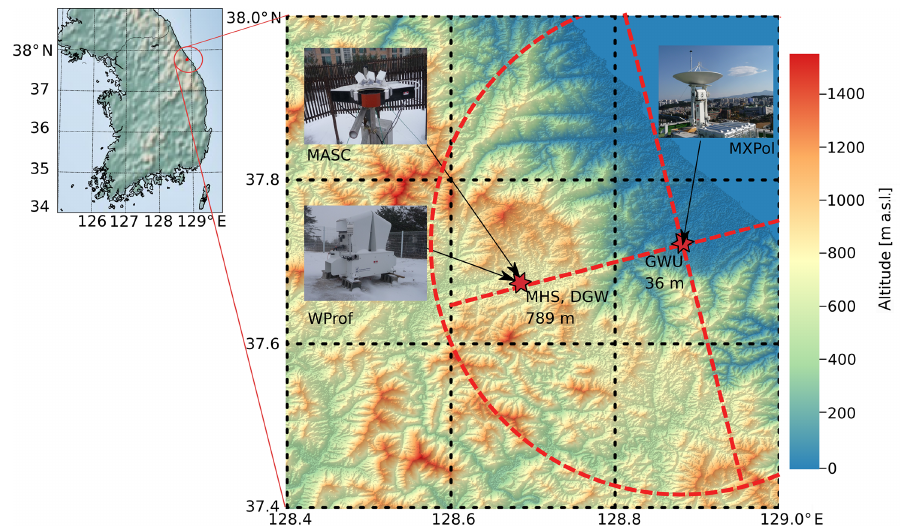
Figure 1. Location of the main measurement sites of ICE-POP 2018 used in this study. A digital elevation model shows the topography of the region and its location within South Korea. The dotted red lines and circle show the extent of the main RHIs (27.2km) and the PPI (28.4km radius), respectively. Table 1. Description of WProf chirps.